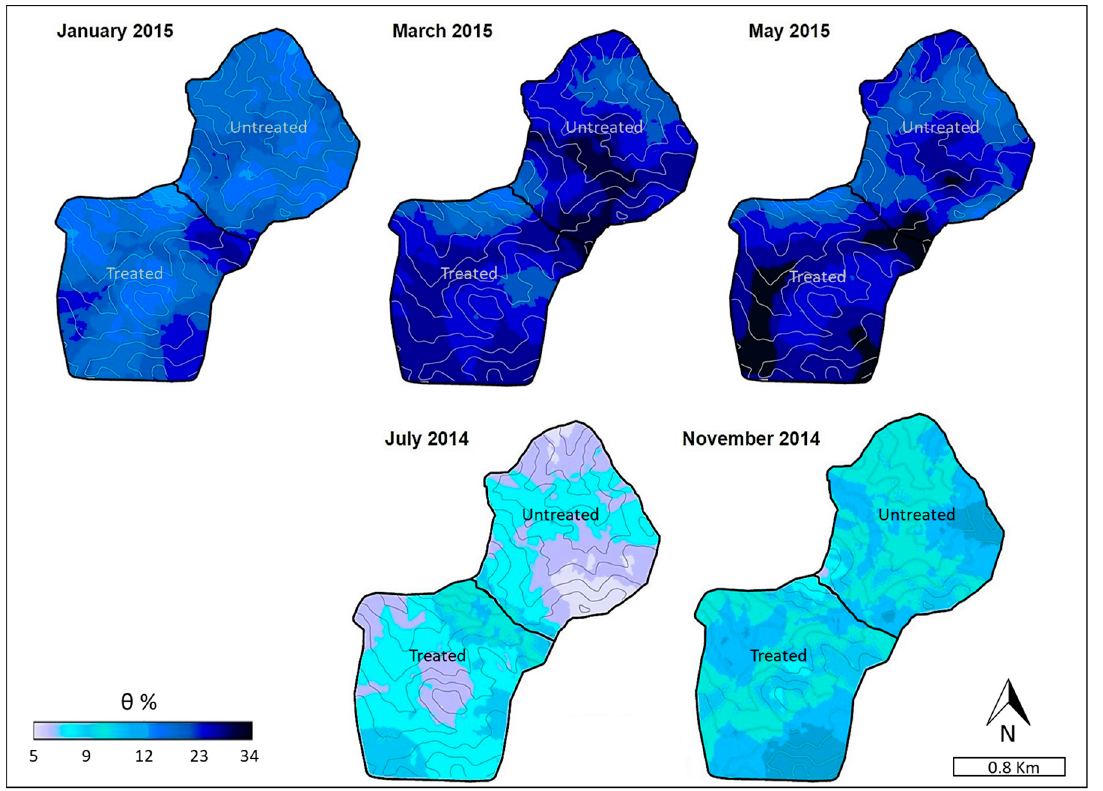
Figure 5. Map of the study site illustrating seasonal changes in percent soil water content ( θ ) in both watersheds. Both the treated watershed and the untreated drain north.